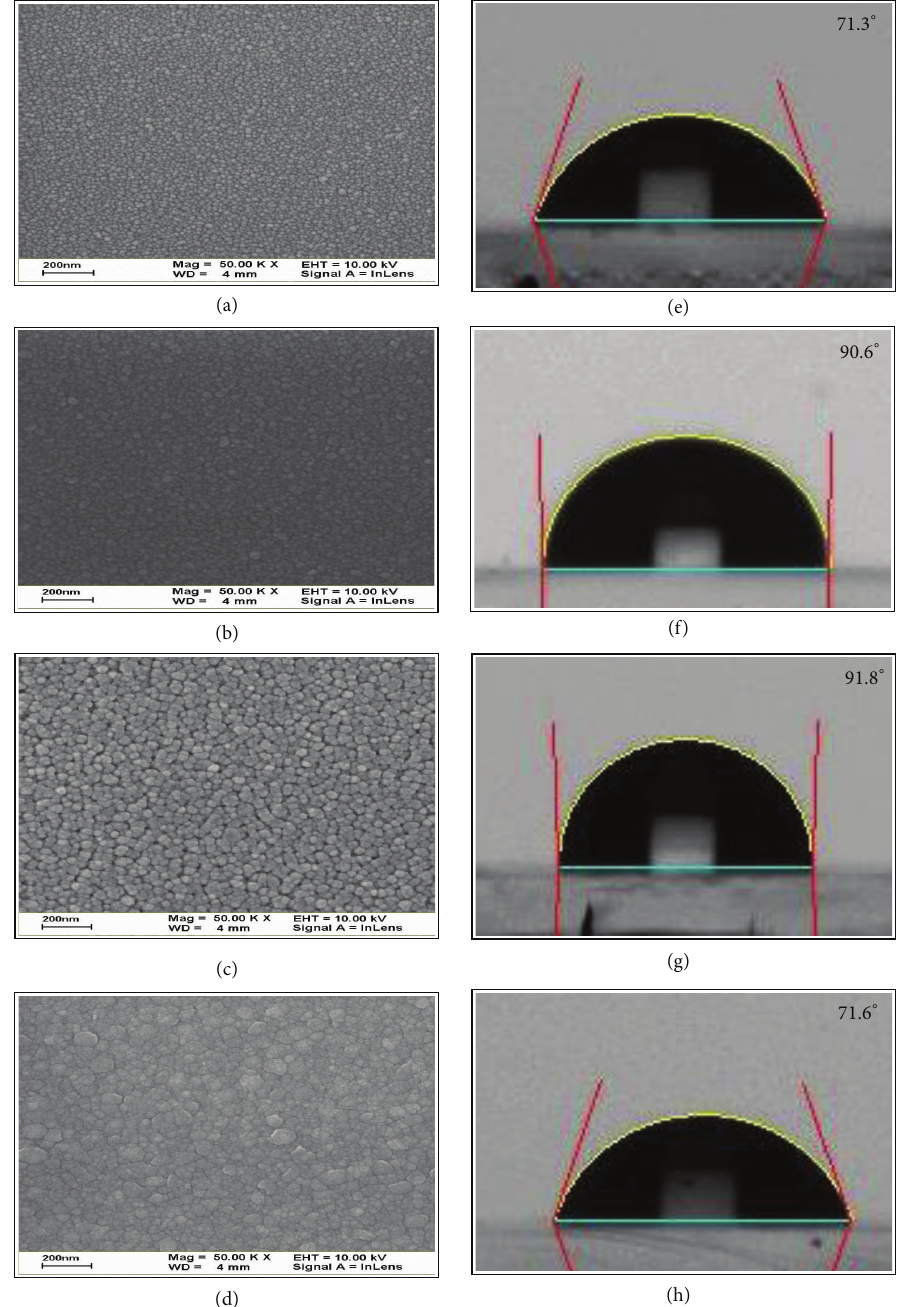
Figure 2: Top view SEM images for the ZnO thin films with deposition powers of (a) 50, (b) 75, (c) 100, and (d) 150W, respectively. The contact angle images for different ZnO thin films corresponded to the right side denoted by (e), (f), (g), and (h),